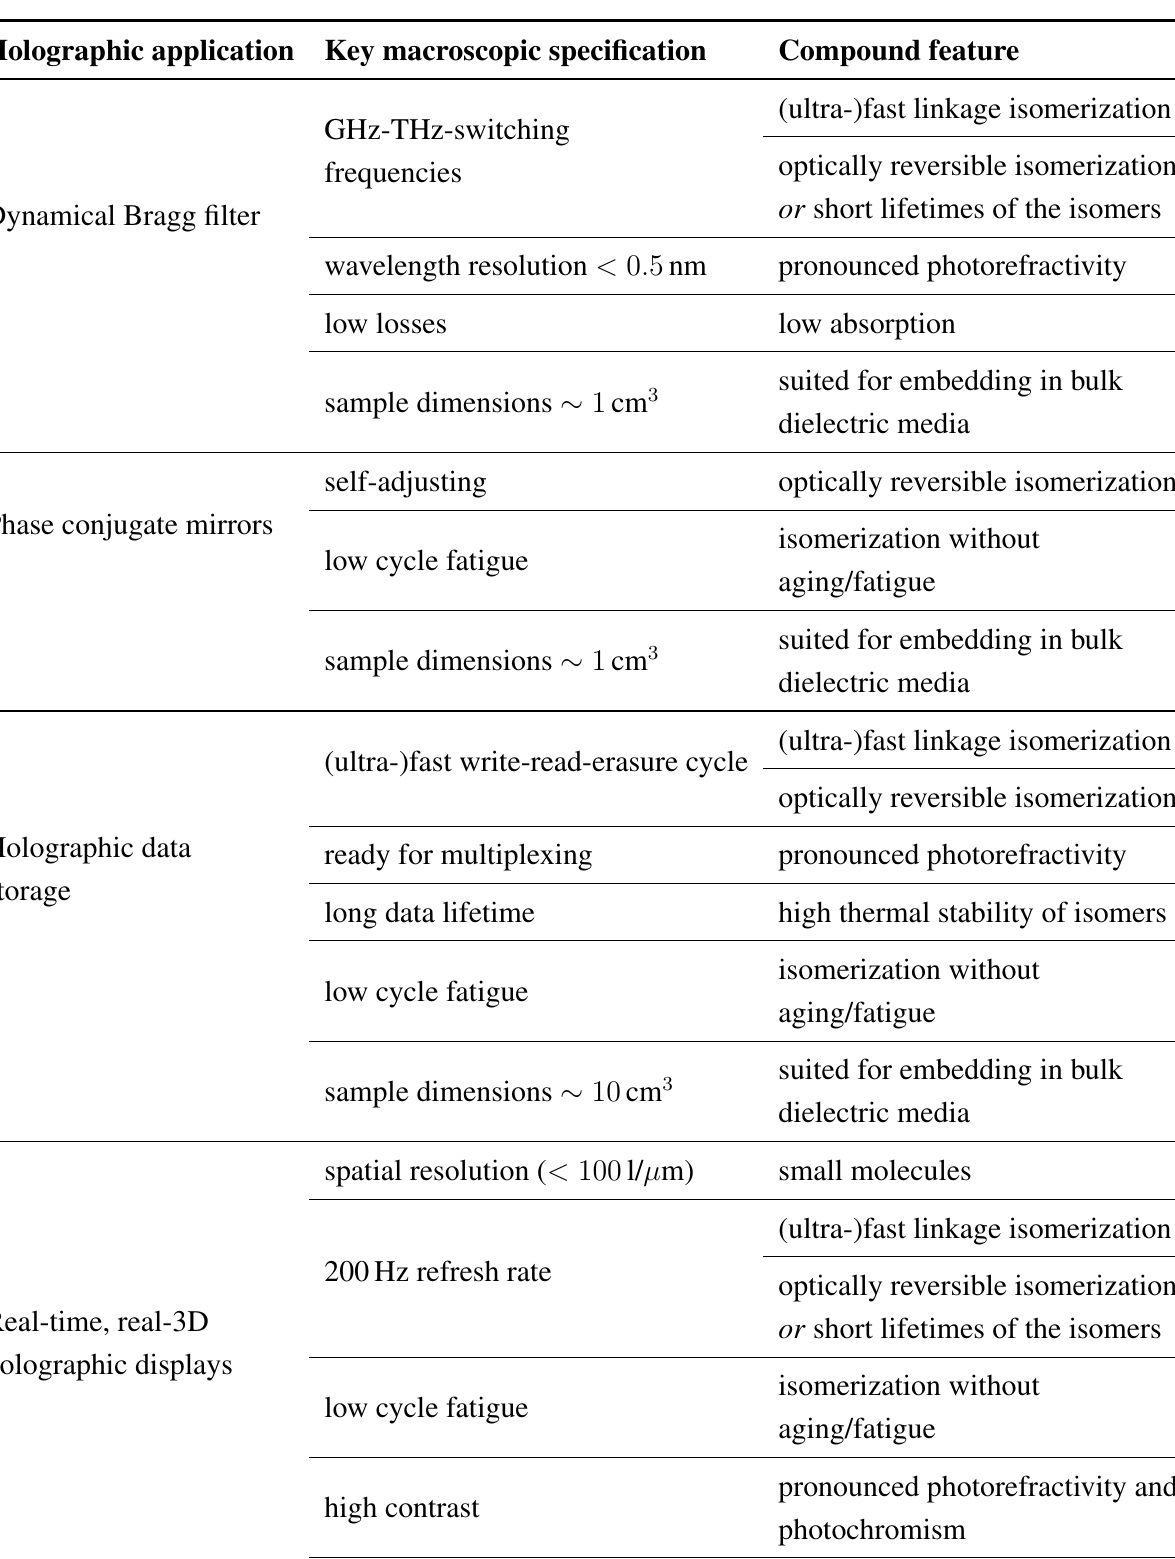
Table 1. Relation between the photophysical properties and features of transition metal compounds with modern holographic applications by taking into account the relevant device